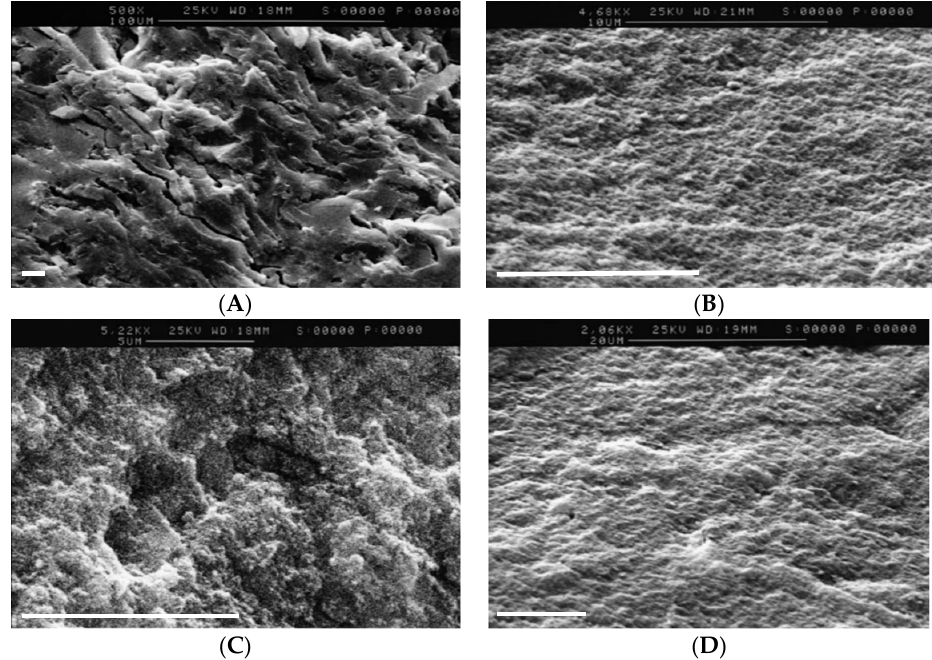
Figure 2. Scanning electron micrographs showing the surface appearance of Eudragit matrices produced by the compaction of lyophilised powders prepared from a dispersion of Eudragit powder in: ( a ) phosphate-buffered saline (PBS)/Tween ® 80, ( b ) plus mannitol or ( c ) trehalose; ( d ) or produced by the compaction of " as received " Eudragit L100 powder alone. The size-bar represents 10 µm.